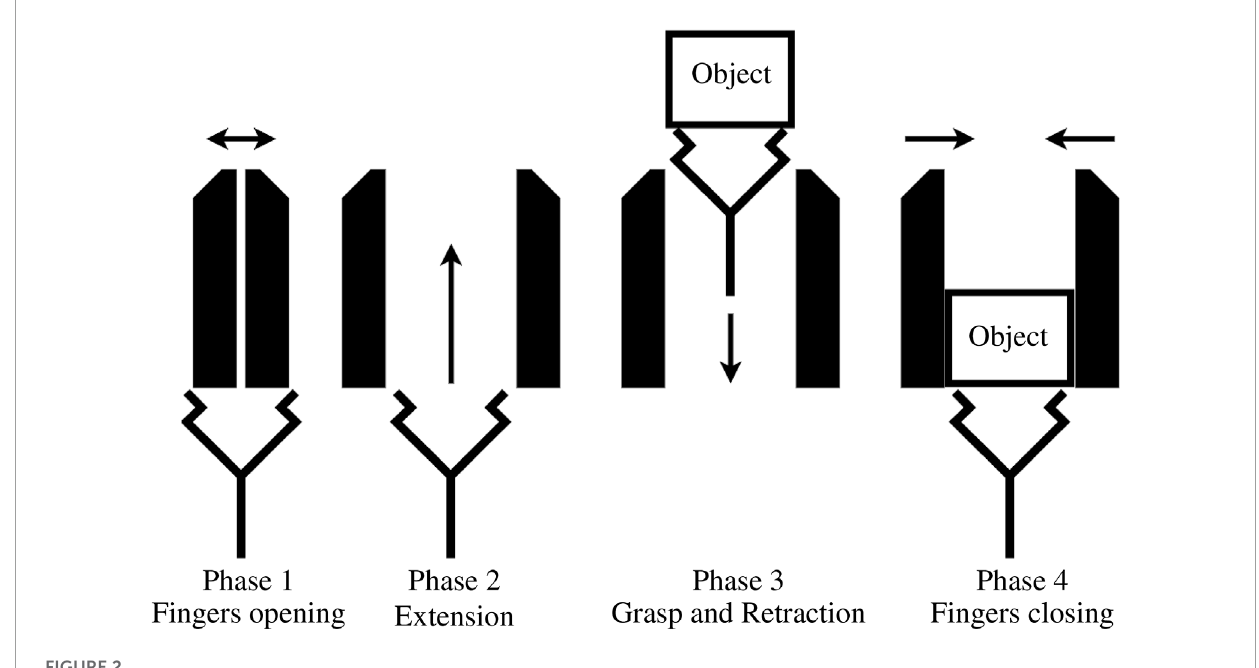
FIGURE 2 Fingers and suction cup motion.